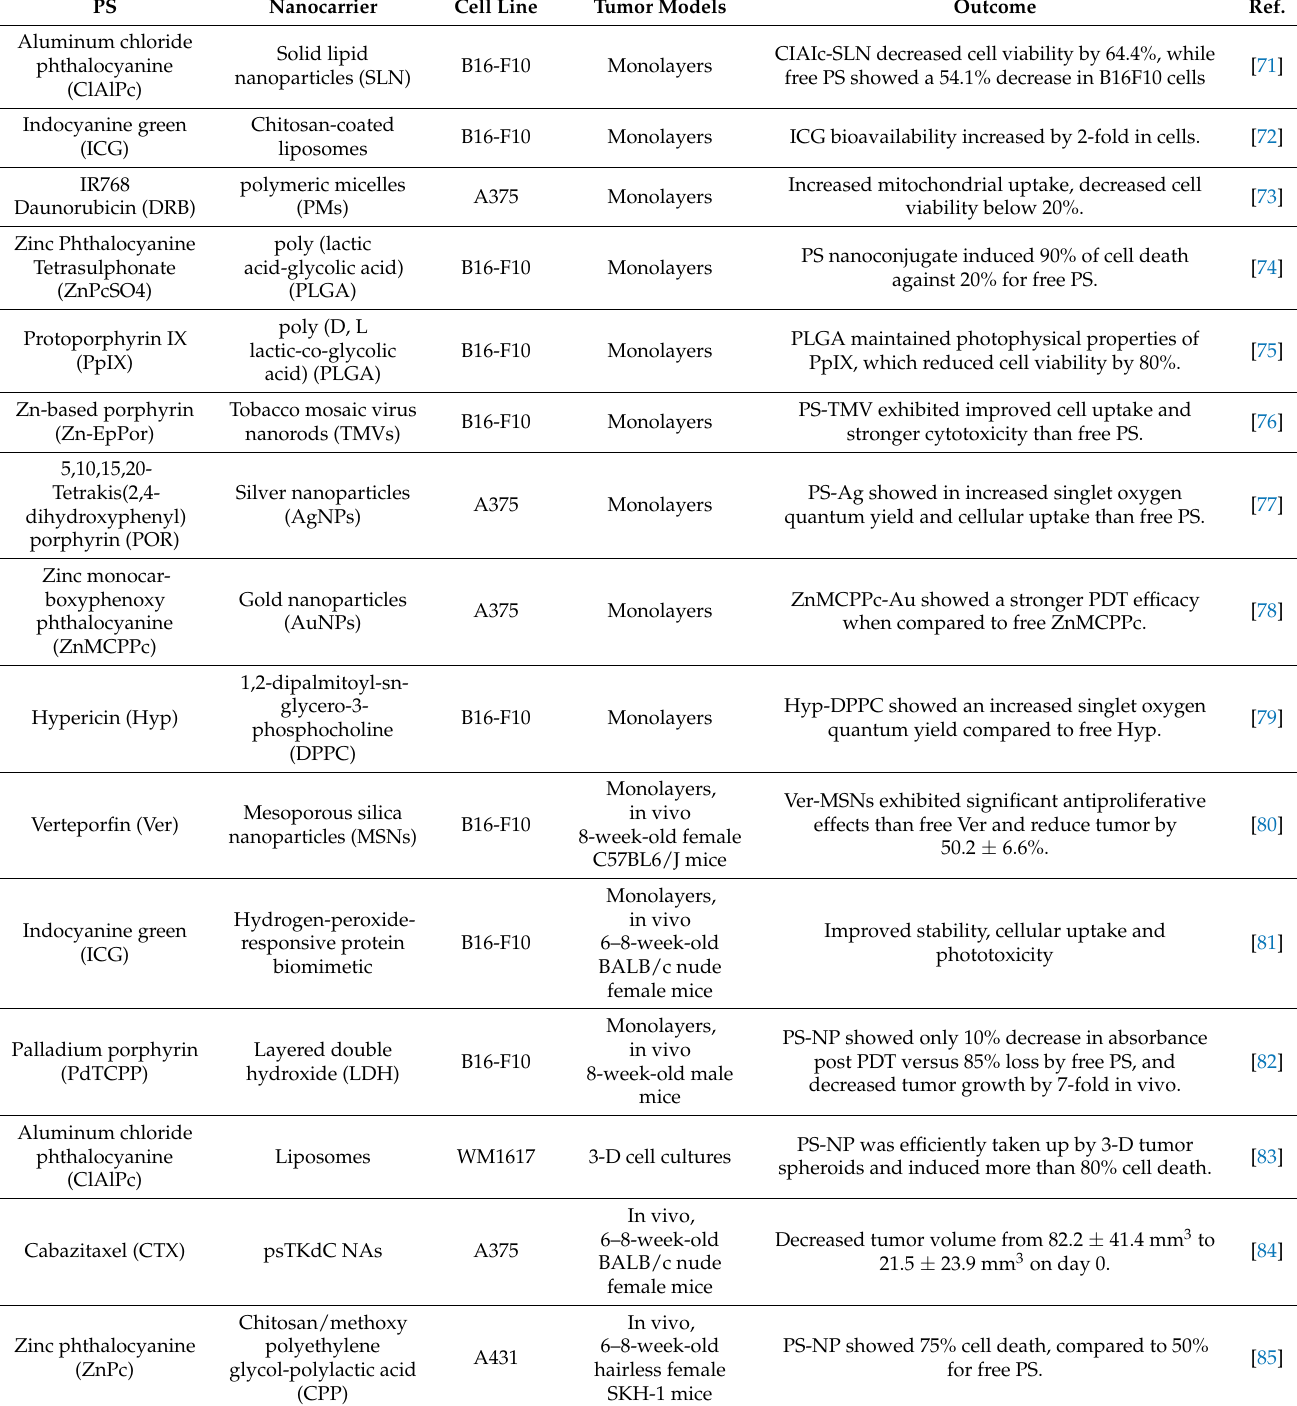
Table 3. Passive targeting PDT-PS nanocarrier systems in metastatic